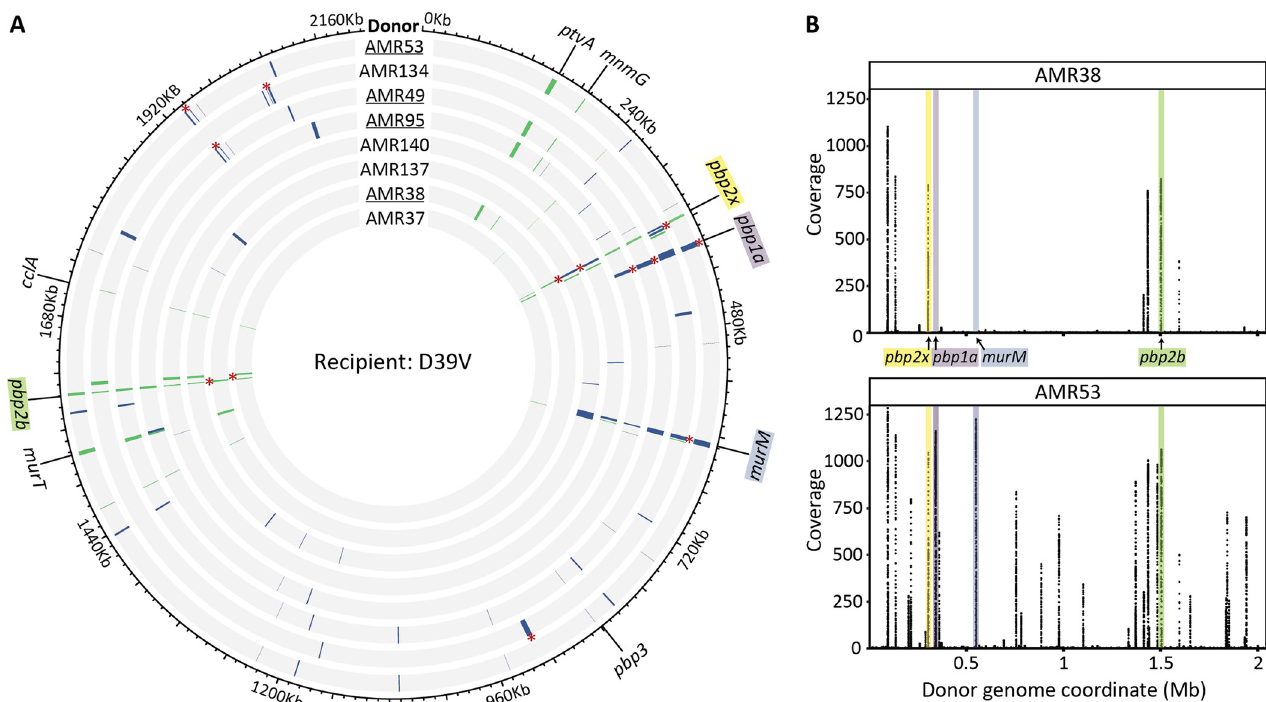
Fig 4. Widespread transformation and uptake of 11A donor DNA in recipient D39V upon AMX selection. (A) Circos plot with detected recombination events in D39V derived strains, arranged from lowest to highest MIC from the center. AMR38 and all derived strains are underlined, AMR37 and all derived strains are not. Grey indicates the sequences matches that of the recipient D39V, while recombination events are colored. Events acquired in the first round of transformation are shown in green, in the second round in blue, and lengths were increased to aid in visualization (see S3 Table for a list of all detected events). Recombination events determined to be non-contiguous are marked with ( � ). Non-contiguous events detected in the first-generation were removed from the data set on the second-generation strains, so are not marked. (B) Coverage of reads mapped competitively to the donor genome and plotted by coordinate beginning at the origin. Recombination events cluster at known β -lactam resistance determinants, pbp2x , pbp2b , murM , and pbp1a .